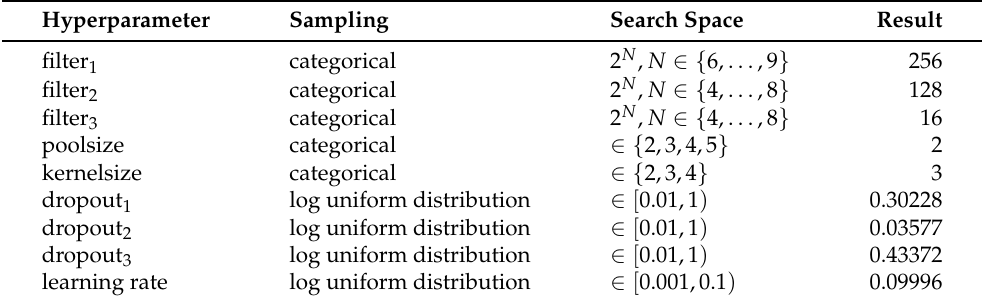
Table 3. Hyperparameter, search space and optimization results for the CNN model.